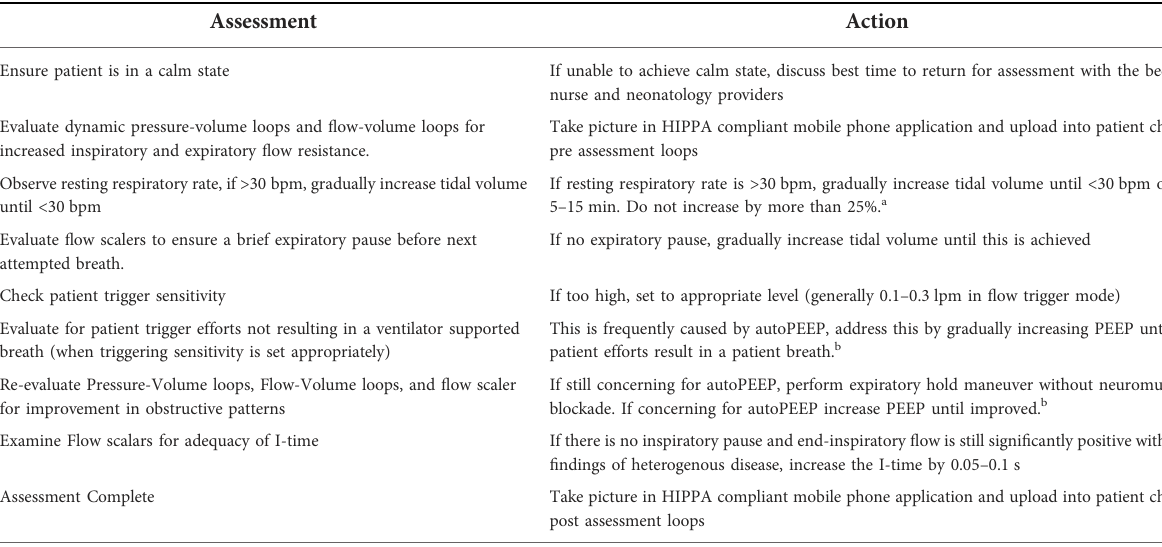
TABLE 1 Process for ventilator